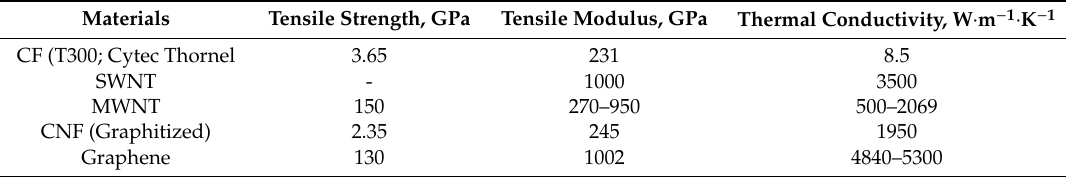
Table 5. Reported characteristics of carbon fibre, carbon nanotube, carbon nanofiber and